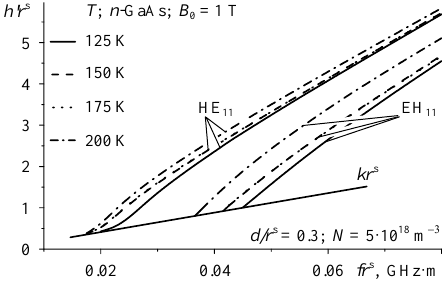
0 0 . 020 . 040 . 06 Fig. 5. Wave phase characteristics of models of gyroelectric n -GaAs semiconductor-dielectric waveguides, when d/r s = 0.3; B 0 = 1 T; N = 5·10 18 m –3 . The insignificantly bigger phase shift to the lower frequencies side appears when temperature T is changing in the models of the waveguides without an external anisotropic dielectric d/r s = 0 layer compared with the characteristics, which are given in Fig. 4.